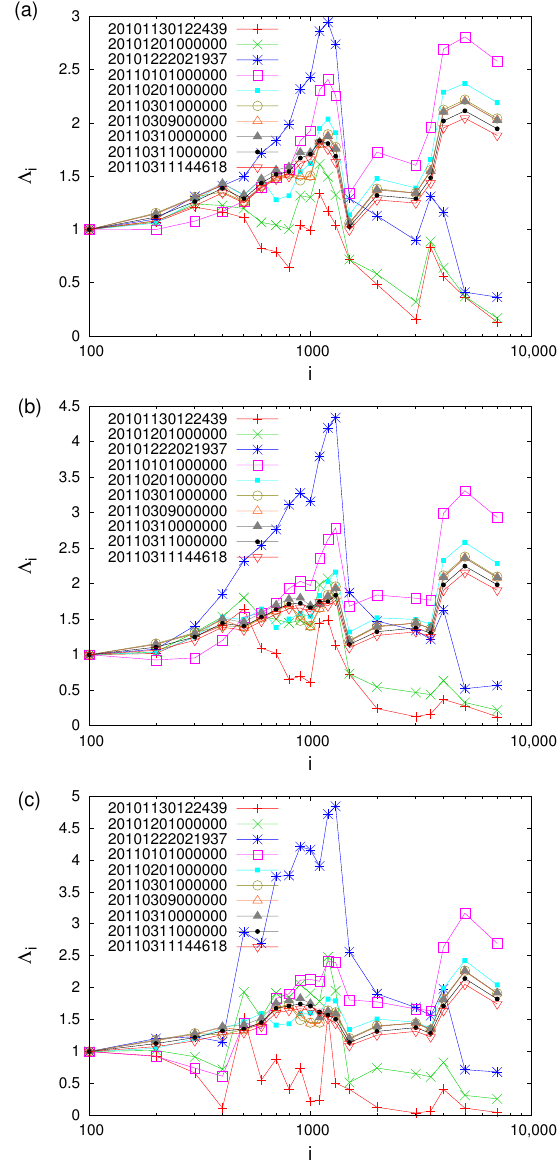
Figure 25. Plot of the Λ i values versus the scale i (number of events) for all M JMA ≥ 3.5 EQs in the entire Japanese region N 46 E 148 since 1 September 2010 ( a ), 1 October 2010 ( b ) and 25 125 1 November 2010 ( c ). The Λ i values have been calculated for each scale up to the following ending dates: 30 November 2010 (pluses in red, just before the M 7.1 EQ on this date), 1 December 2010 (crosses in green), 22 December 2010 (asterisks in blue, just before the M 7.8 EQ that occurred on this date), 1 January 2011 (open squares in magenta), 1 February 2011 (solid squares in cyan), 1 March 2011 (open circles in olive green), 9 March 2011 (open triangles in orange, at 00:00 LT, thus almost 12 h before the M 7.3 EQ on 9 March 2011), 10 March 2011 (gray filled triangles, at 00:00 LT thus almost 12 h after the M 7.3 EQ on 9 March 2011), 11 March 2011 (solid circles in black, at 00:00 LT, thus almost 15 h before the mega-earthquake occurrence) and 11 March (inverted red triangles, almost 10 min before the M 9 Tohoku EQ). The time format in the figure keys is YYYYMMDDhhmmss in Japan Standard Time. Taken from Ref.